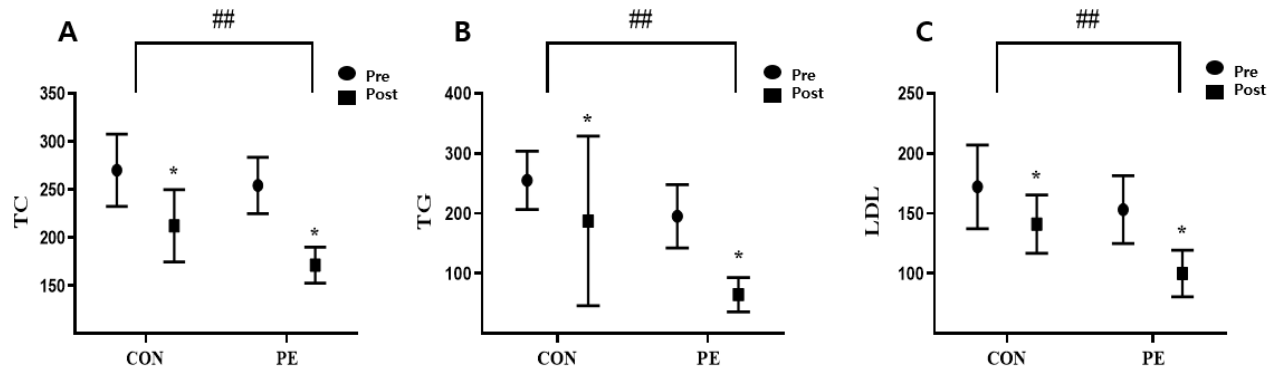
Figure 2. Effect of blood lipids profile according to Pilates. Bars represent mean ± SD (CON: n = 8, PE: n = 8). * p < 0.05 from pre to post. ## p < 0.01 change (post–pre) between groups.